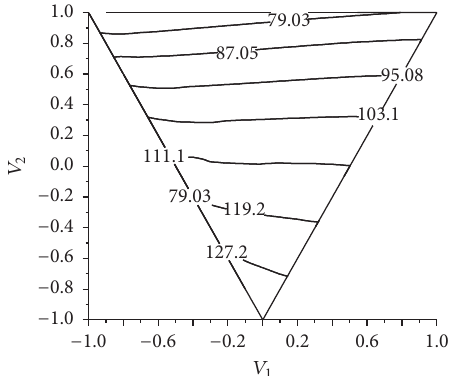
Figure 3: Flutter velocity contours for orthotropic sandwich panel with no gradient change ( 𝑉 3 = 0 , GF = 0).